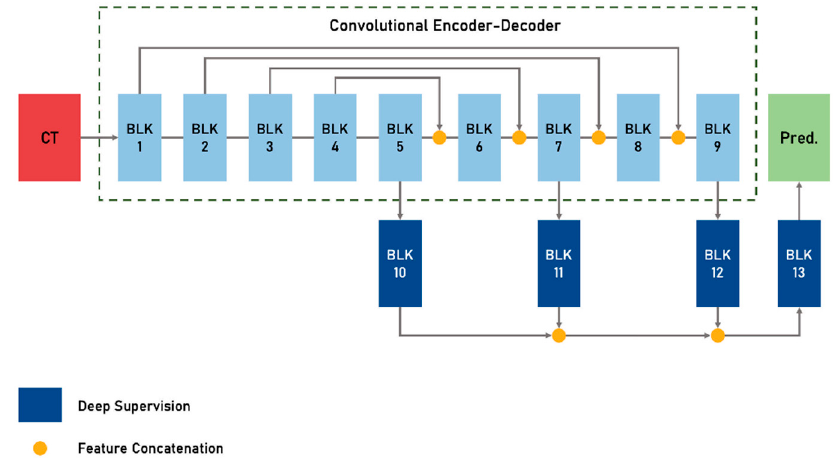
Figure 1. Deep image-to-image network (DI2IN). The front part is a convolutional encoder-decoder network with feature concatenation, and the backend is a deep supervision network through multi- level. Blocks inside DI2IN consist of convolutional and upscaling